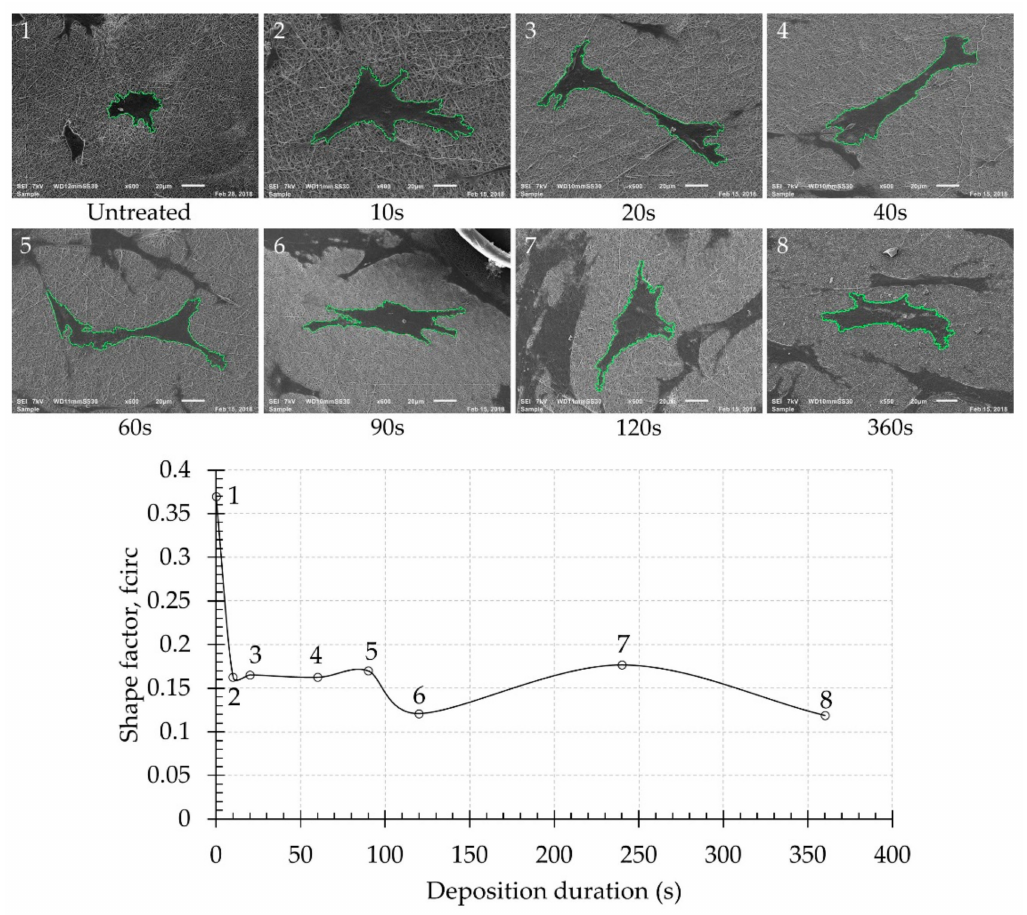
Figure 10. Evolution of the average shape factor of the adherent cells for the untreated and PPF-NFs with di ff erent deposition durations on day